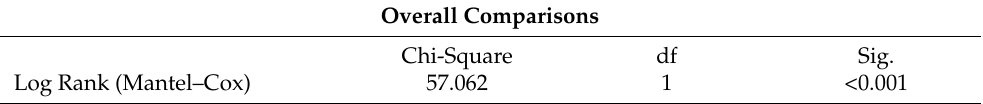
Table 6. Test of equality of survival distribution at different treatment levels (Groups 2a and 2b).